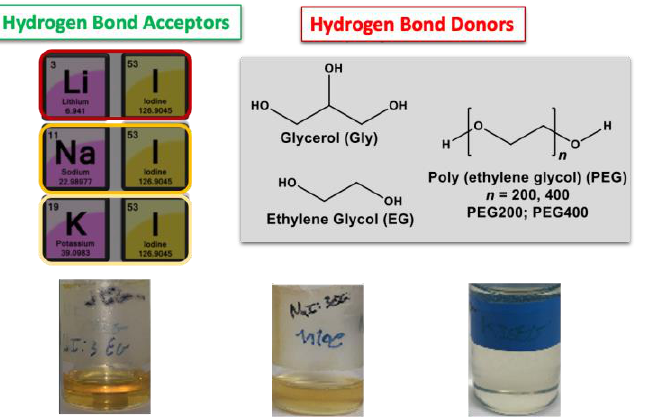
Figure 1. Chemical Structures of Hydrogen Bond Acceptors (HBA) and Donors (HBD) selected for the preparation of alkali iodide Deep Eutectic